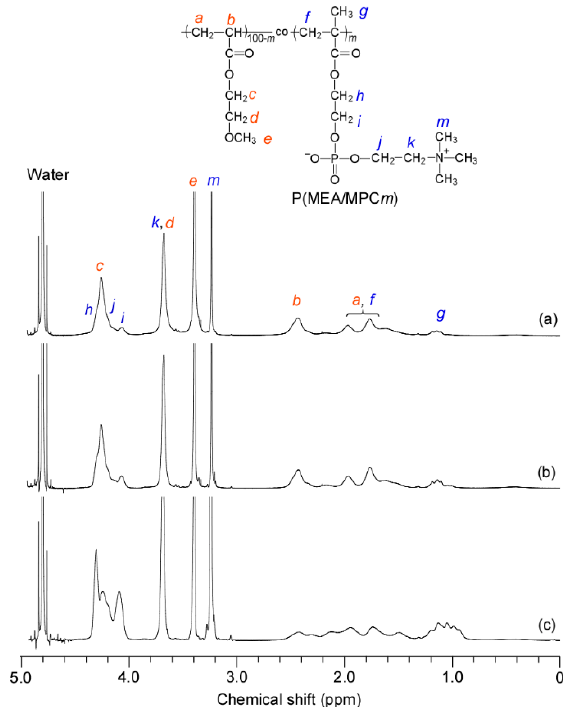
Figure 4. 1 H NMR spectra for ( a ) P(MEA / MPC 6 ), ( b ) P(MEA / MPC 12 ), and ( c ) P(MEA / MPC 46 ) in D 2 O at room temperature.